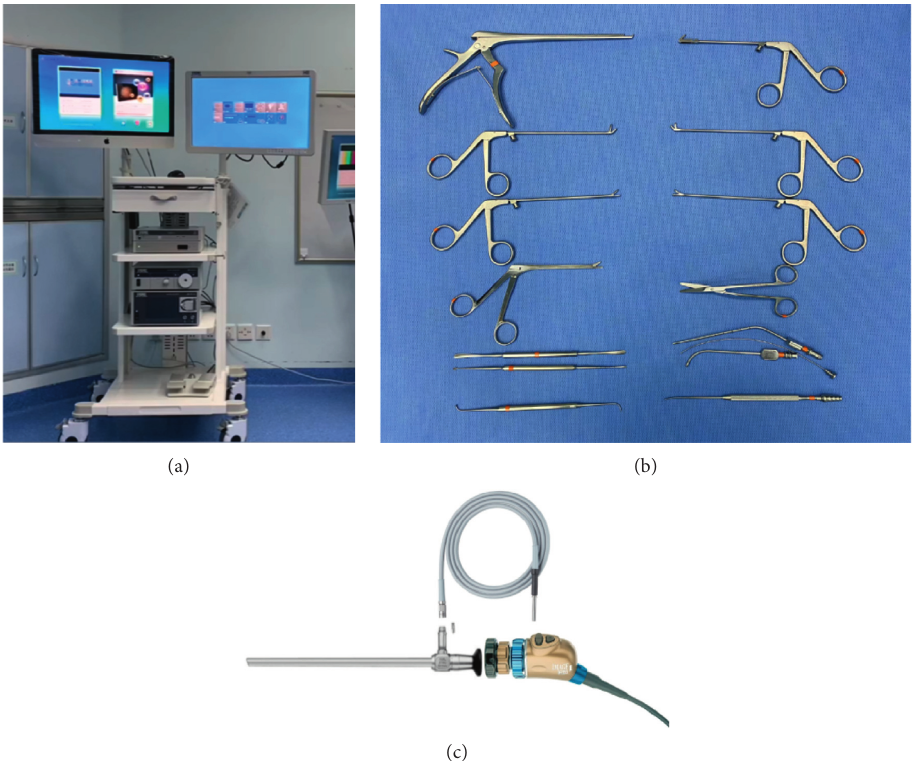
Figure 1: Zero-degree, 4 mm diameter rod-lens rigid telescope system and microsurgical instruments.